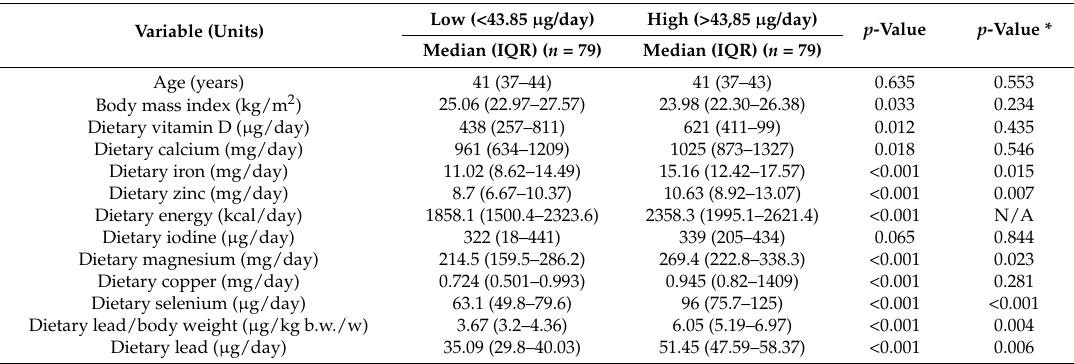
Table 2. Sample characteristics regarding lead dietary intake in premenopausal women.